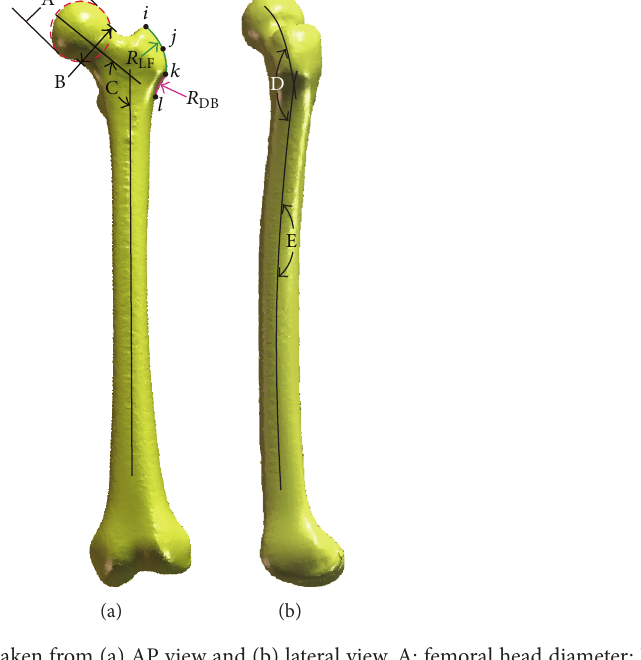
Figure 1: Measurements of femoral dimensions taken from (a) AP view and (b) lateral view. A: femoral head diameter; B: narrowest neck width; C: neck-shaft angle (NSA); D: sagittal NSA; E: medullary radius of